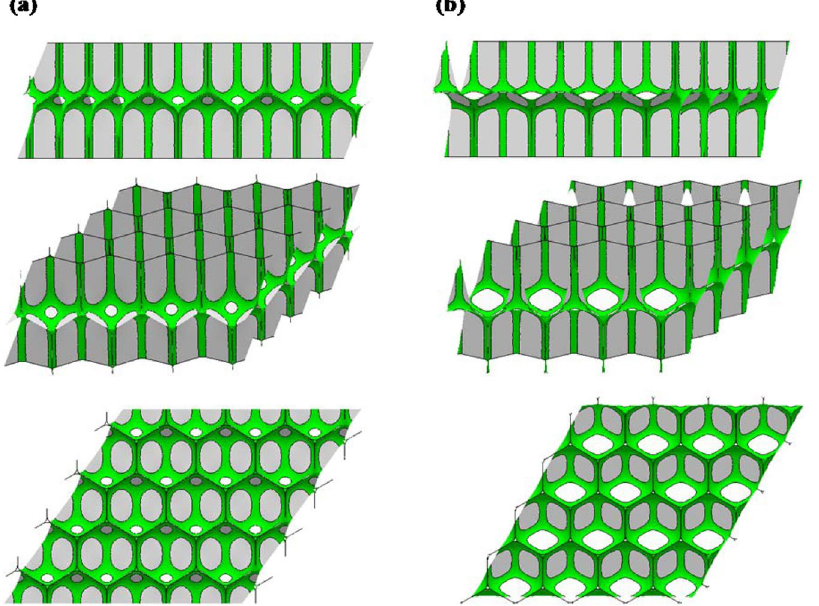
Figure 7. Surface Evolver simulations of two kinds of bilayer monodisperse systems for the wet foams: ( a ) Tóth structure. ( b ) Honeycomb structure. The green part represents Plateau borders; the grey part represents foam films. The liquid fraction is equal to the ratio of the green part volume the unit cell volume. The liquid fraction shown here is 2.00%. As in Fig. 2, the white ovals in figures are just some surfaces oriented for particularly bright